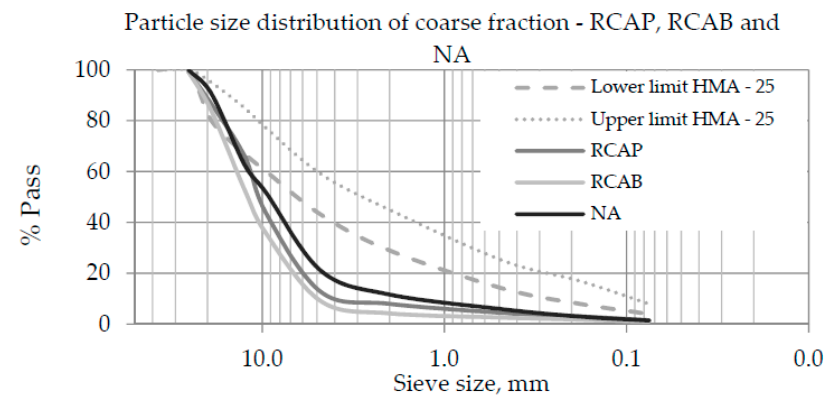
Figure 5. Particle size distribution curves of the coarse fractions of the recycled concrete aggregate from a pavement, aggregate from the demolition of a building (RCAB), and natural aggregate (NA). Table 5. Specific gravity and water absorption of coarse NA, RCAP, and RCAB.